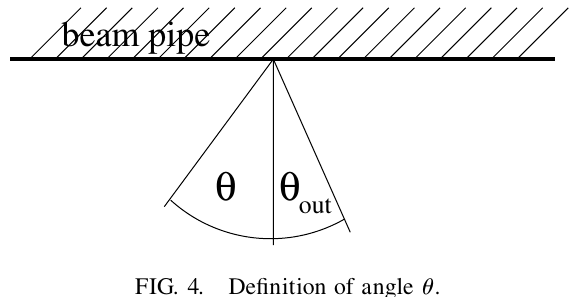
FIG. 4. Definition of angle % .